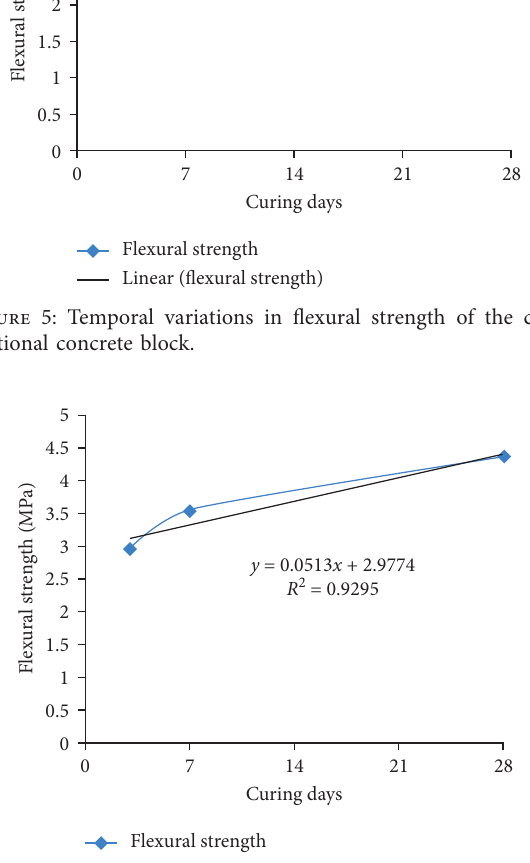
Figure 6: Temporal variations in flexural strength of treated ef- fluent imbibed concrete block.